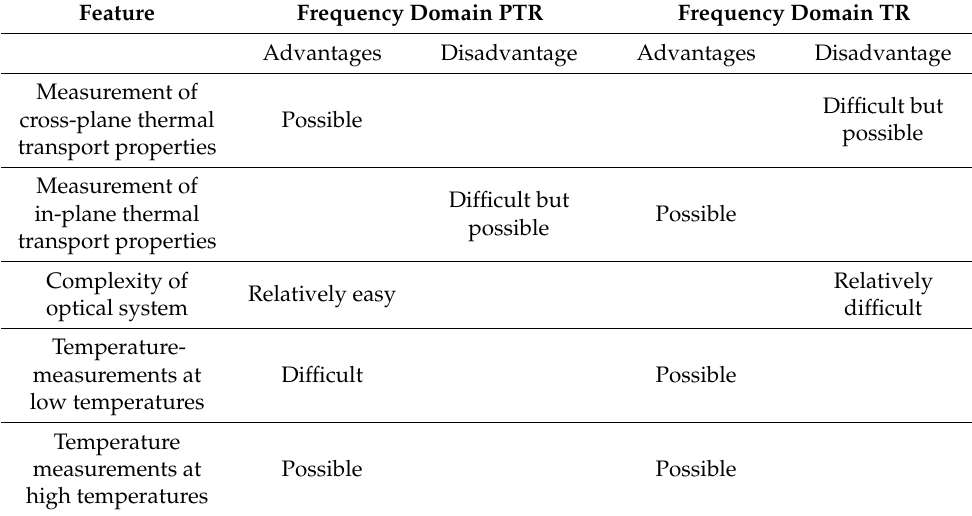
Table 5. The summary of frequency-domain photothermal radiometry (PTR) and frequency- domain